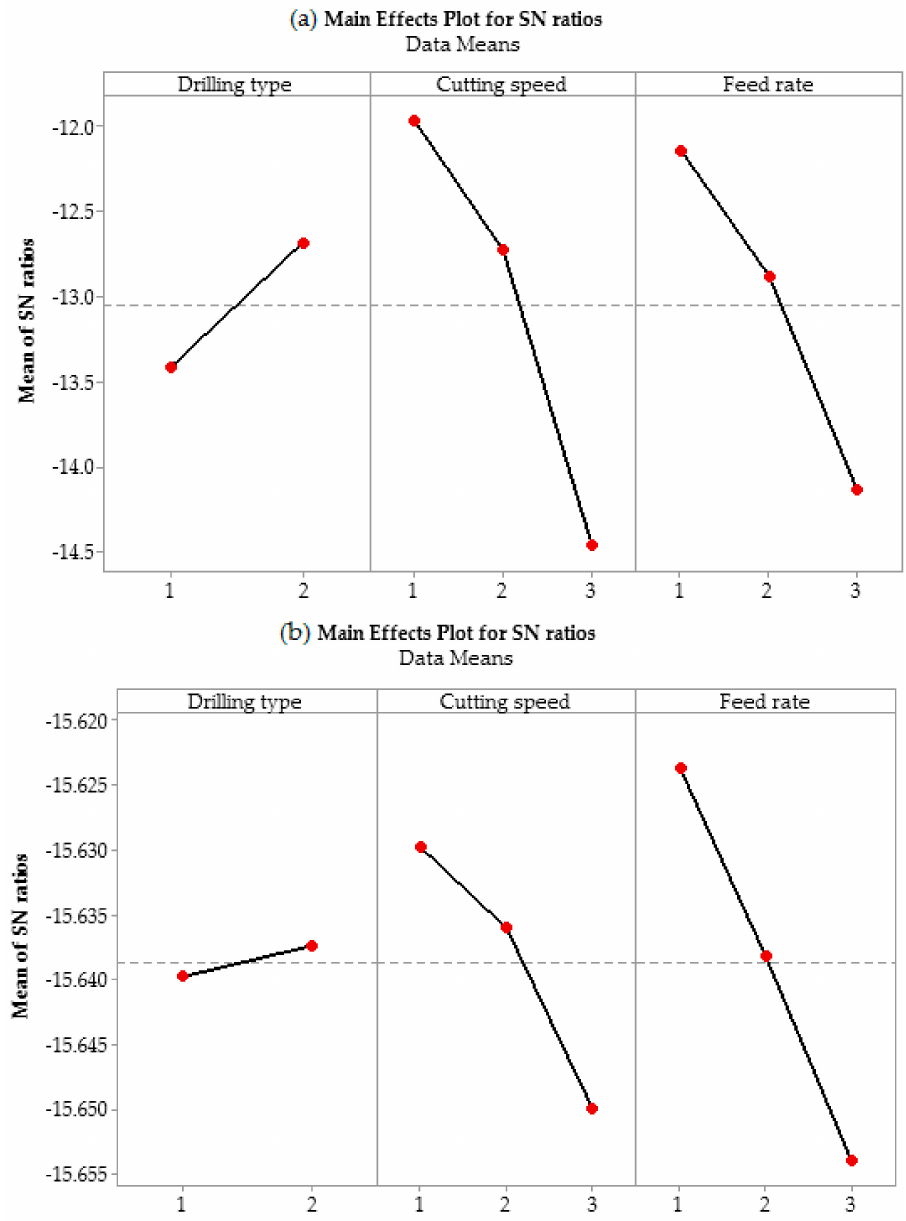
Figure 4. The e ff ect of drilling parameters on ( a ) surface roughness and ( b ) hole